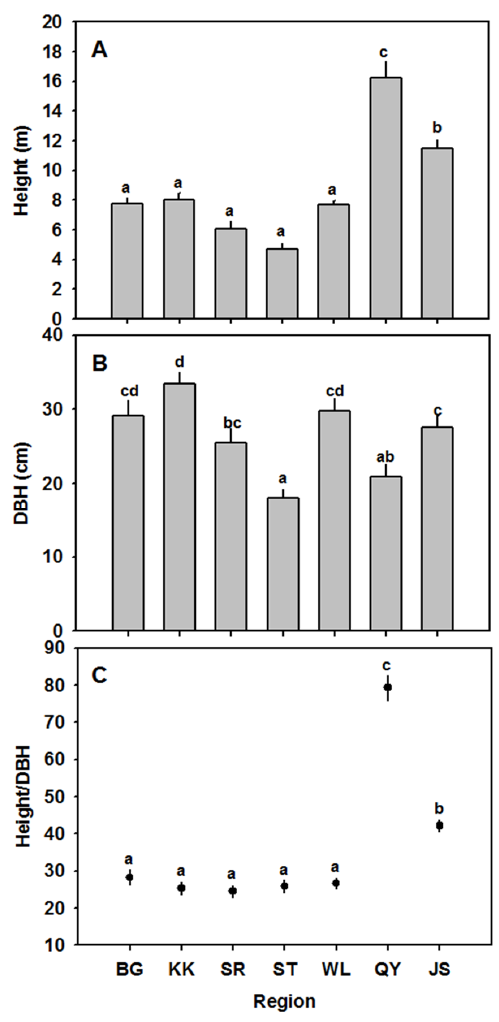
Figure 3. Comparison of the growth characteristics of Siberian elm from Mongolia (Bayan Gobi, BG; Khugnukhan, KK; Selenge Steppe, ST; Selenge River, SR), China (Qingyuan, QY; Wulanaodu, WL) and Korea (Jeongseon, JS). ( A ) The average heights; ( B ) The average diameter; ( C ) The average ratio of height to diameter. The different letters indicate significant differences according to Duncan’s multiple range tests at a 5% significance level.